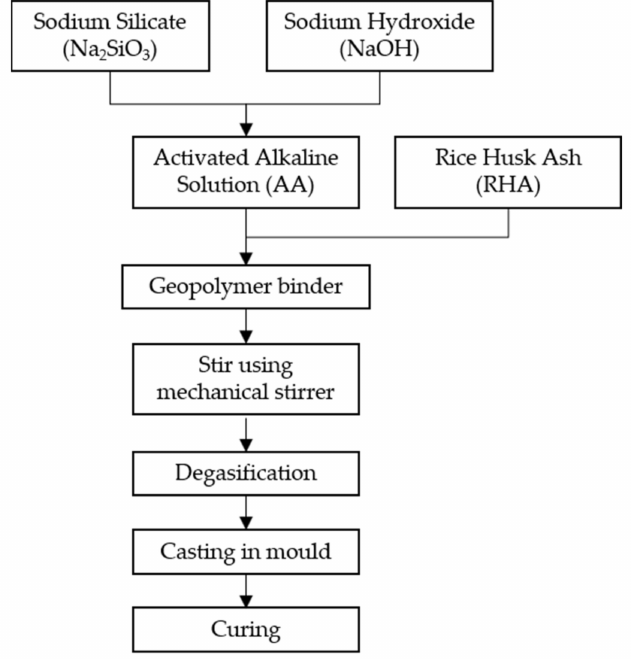
Figure 1. Flow chart for the fabrication of RHA-based geopolymer binder.